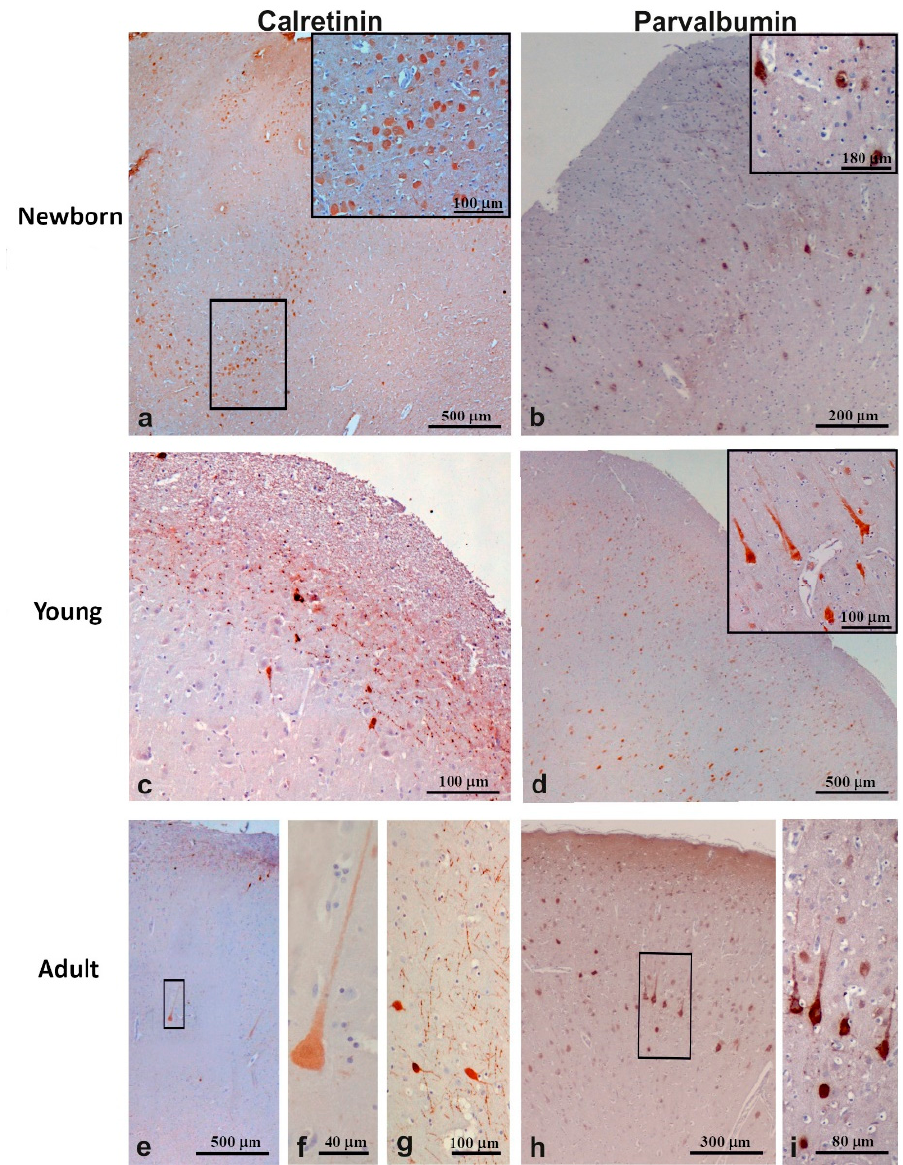
Figure 4. Immunocytochemistry of calcium-binding proteins in the motor cortex (M1) of newborn ( a , b ), young ( c , d ), and adult ( e – i ) pigs. Note the network of CR-ir cells in the outer layer of M1 from young and adult pigs ( c , g ) . PV-ir cells of M1 from newborns (inset of b ) display a different shape compared to one from young (inset of d ) or adult ( i ) pigs. Inset of ( a ) is a high magnification of the squared zone. ( f , i ) display high magnifications of squared zones in ( e , h ), respectively. In all analyzed fields of M1, PV and CR co-expression were not seen in newborn, young, or adult pigs (Figure